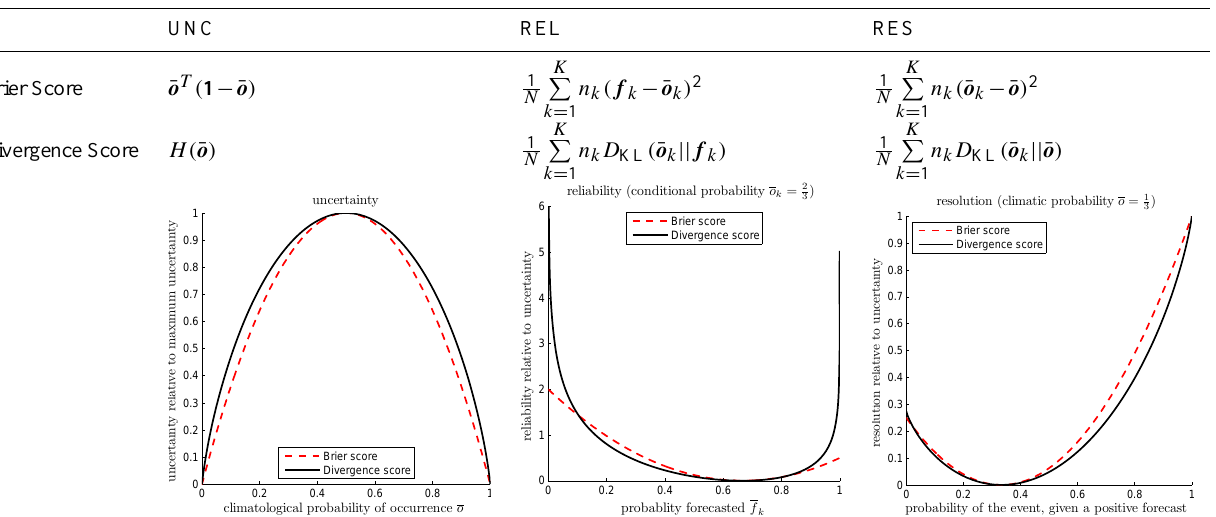
S.V.Weijsetal.: Hydrologicalforecastevaluationusinginformationtheory